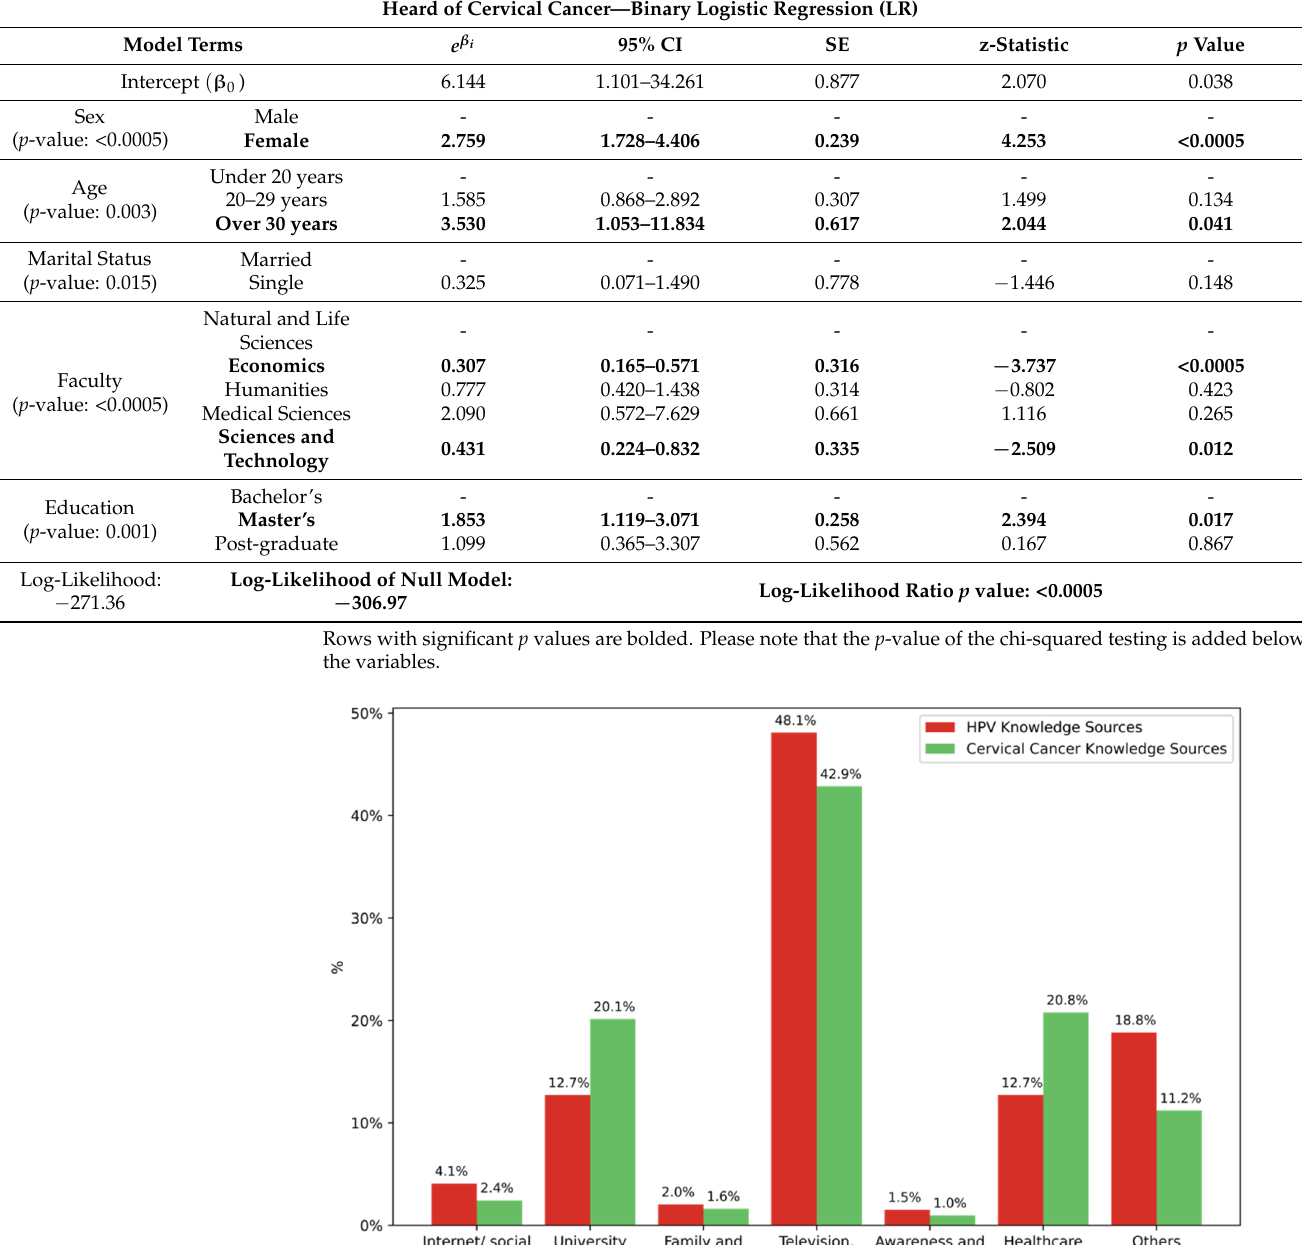
Table 2. Logistic regression model outlining determinants predicting having heard of cervical cancer previously.